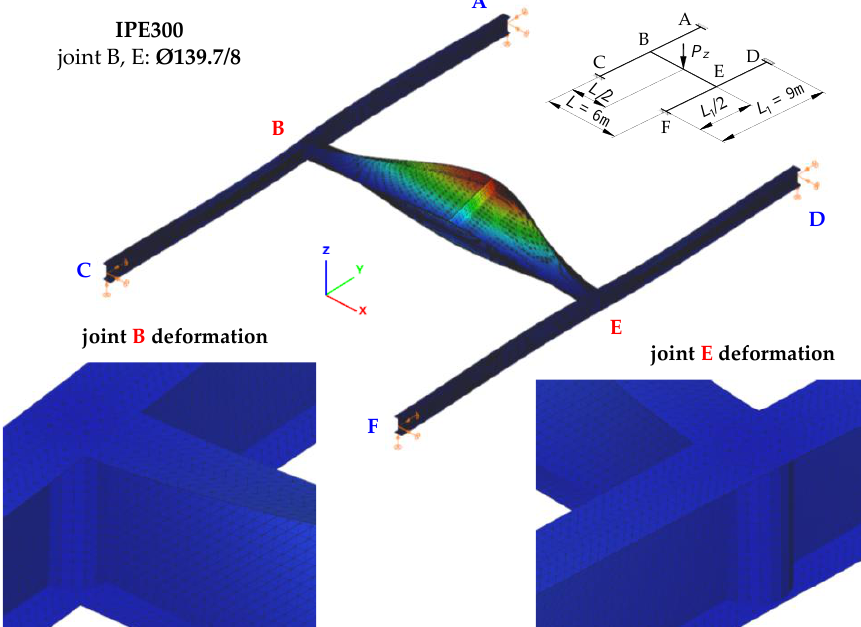
Figure 10. The mode of stability loss in exemplary H-grillage modelled in ConSteel software — shell model. Additionally, the second ( P z,cr, 2 = 400.3 kN) and the third ( P z,cr, 3 = 795.6 kN) eigen- values of the critical load, similarly to the two previous simulations, correspond to the lateral torsional buckling mode of the B–E main (critical) beam according to two or three half-wavelength, respectively.